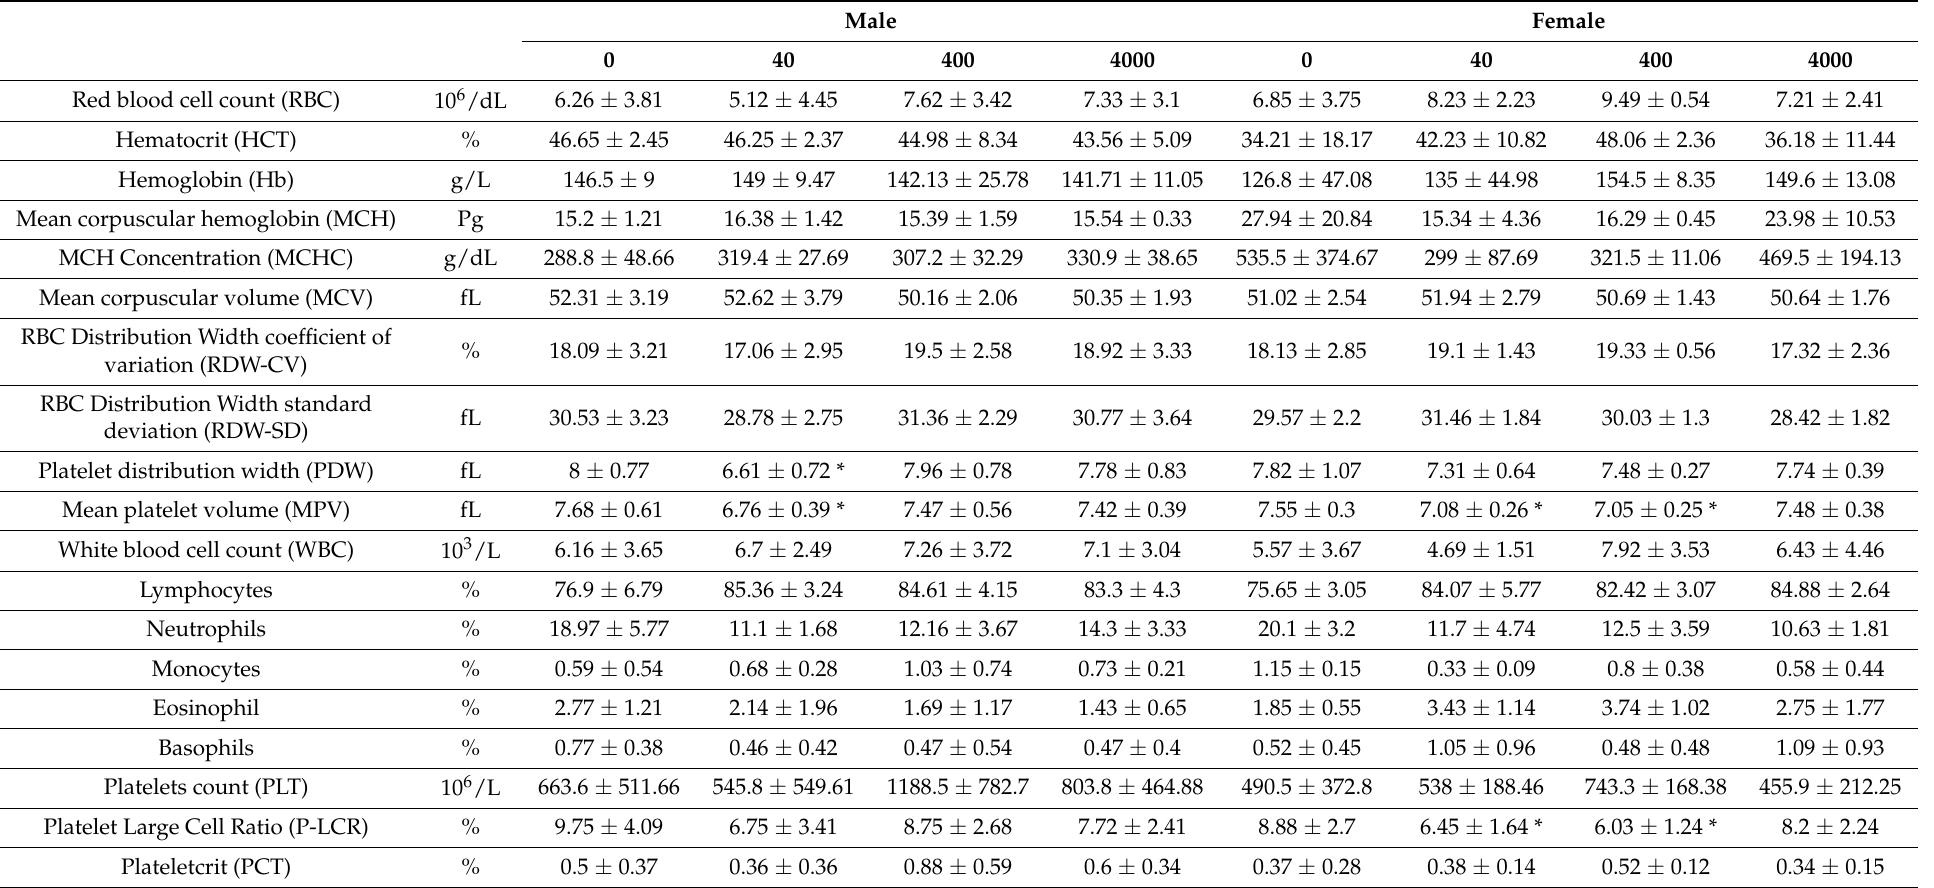
Table 5. Hematology value changes in male and female ICR mice after oral administration of L. paracasei PS23